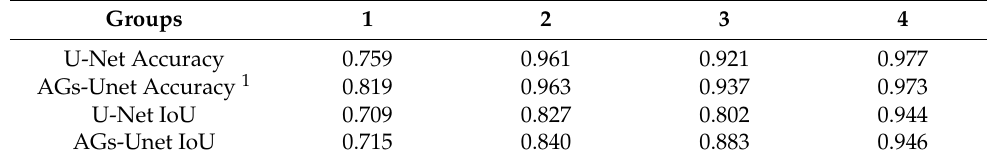
Table 3. U-Net IoU, U-Net Accuracy, AGs-Unet IoU, and AGs-Unet Accuracy Statistics. Groups